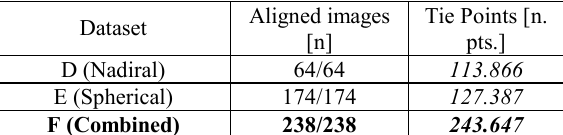
Table 7. Dataset D, E and F, with the number of aligned images and the number of tie points in the sparse cloud.